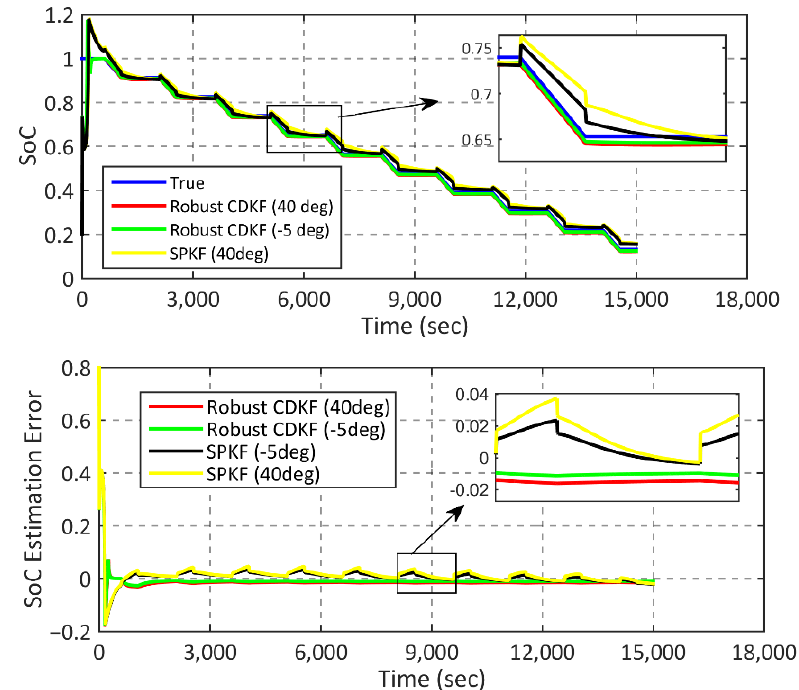
Figure 14. SoC estimation (cell #3).